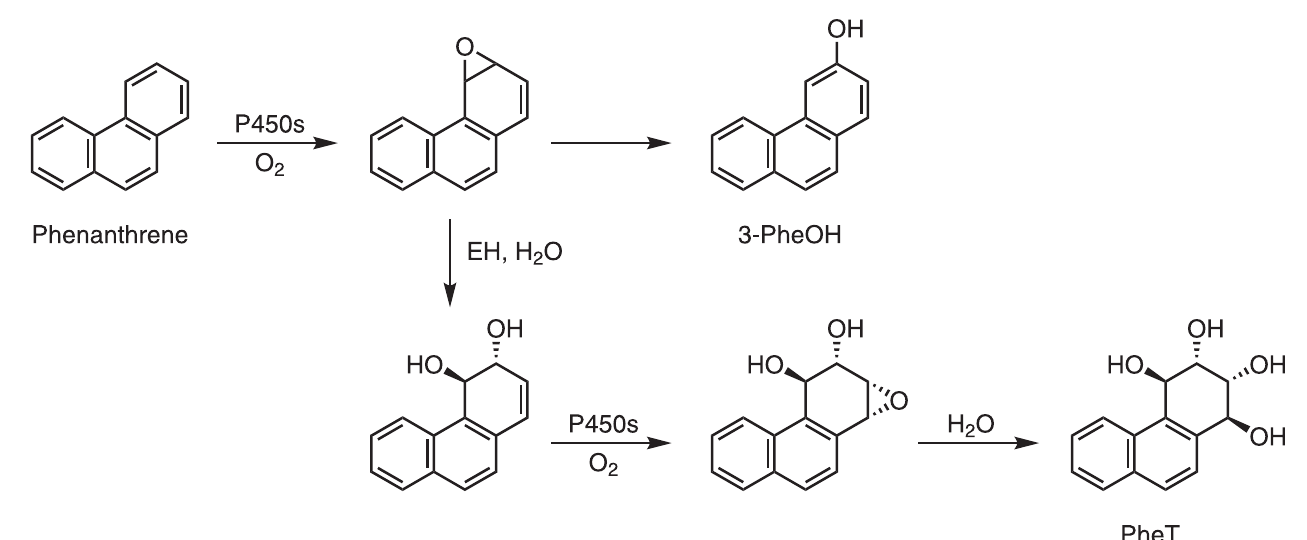
Fig 1. Metabolism of phenanthrene to 3-PheOH and